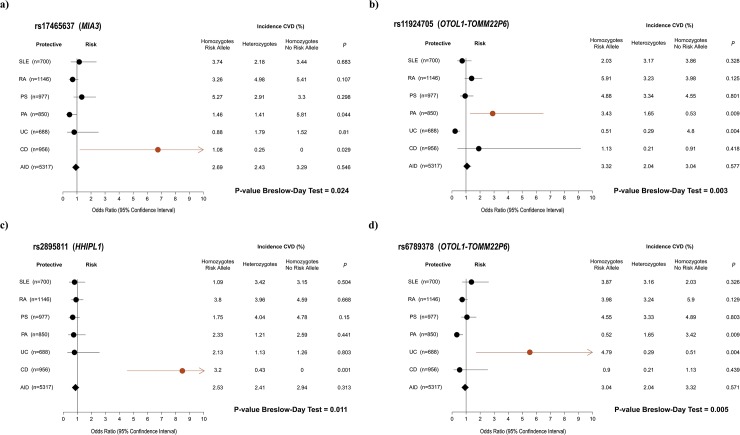
Genetic variants showing heterogeneous genetic effects on CVD risk across autoimmune diseases.For each associated SNP (A: rs17465637. B: rs11924705. C: rs2895811. D: rs6789378) the Odds Ratio (OR, black dots) and 95% confidence intervals (horizontal lines) are shown for each of the 6 autoimmune diseases and the combined autoimmune cohort (AID). The SNPs showing a significant association with CVD risk in an autoimmune disease are highlighted in red. For each of the three genotypes of each SNP (risk allele homozygous, heterozygous, non-risk allele homozygous), the incidence of CVD is described in the accompanying table.